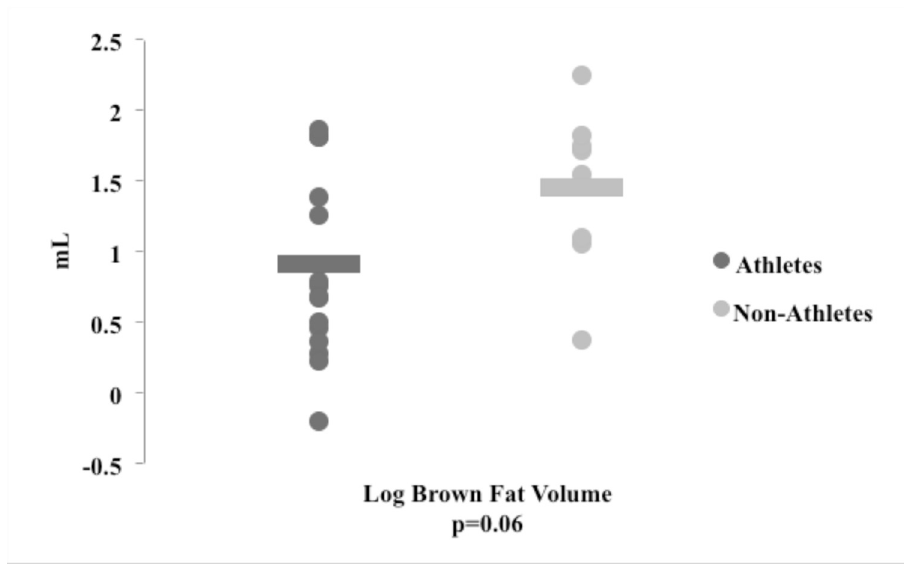
Fig 2. Brown Fat Volume Differences between Athletes and Non-Athletes. Brown fat volume trended lower in athletes (dark grey) compared to non-athletes (light grey).